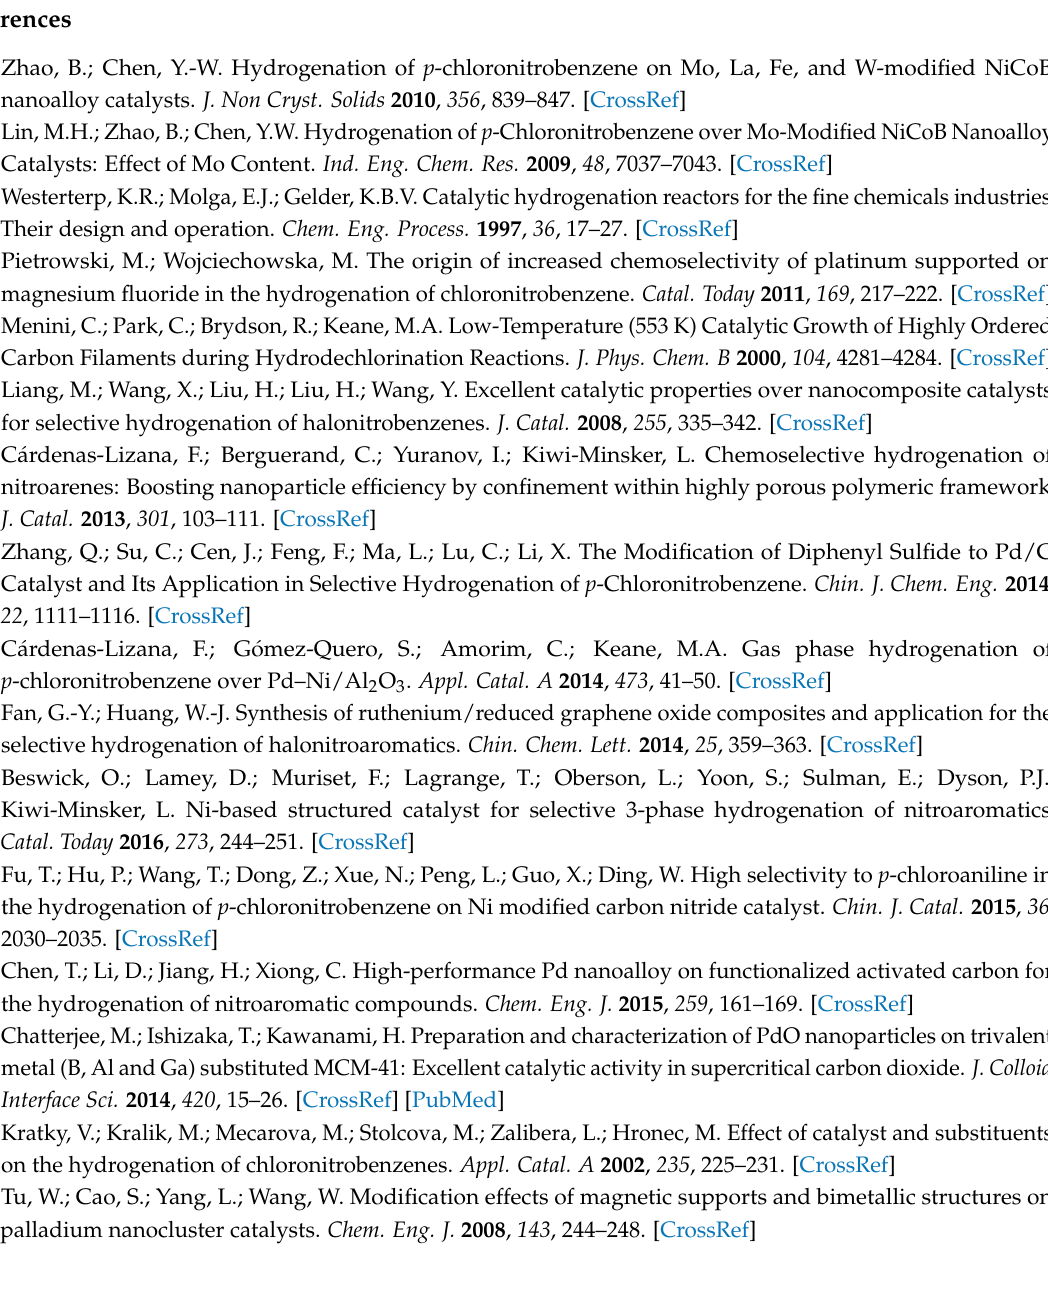
Figure S1: N 2 adsorption–desorption isotherms and pore size distributions, and Figure S2: HRTEM images and Metal particle size distribution